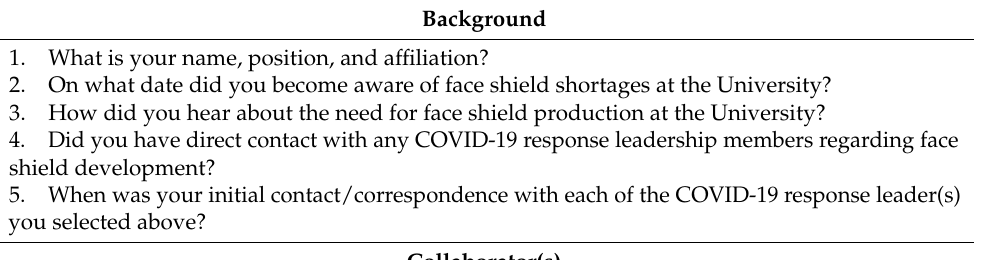
Table 1. Questionnaire administered to face shield response effort